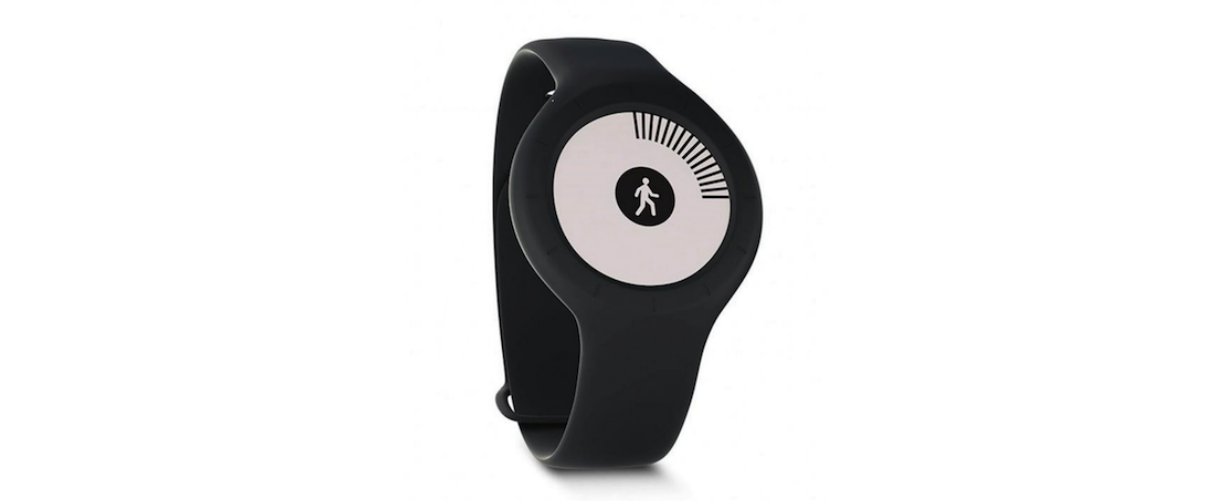
Figure 1. The Nokia Go wearable activity and sleep